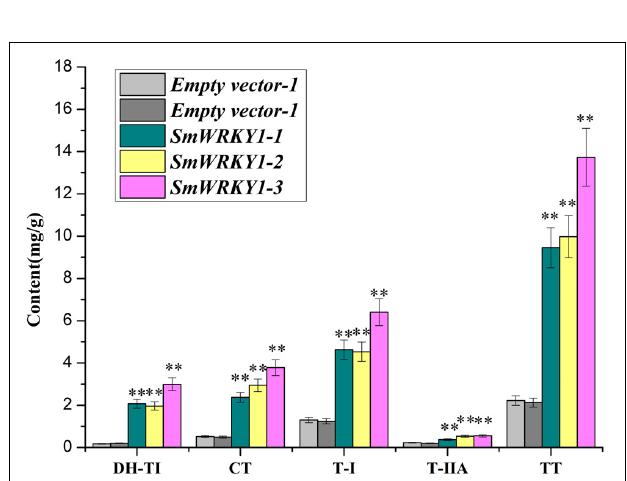
FIGURE 8 | The production of tanshinone in SmWRKY1 transgenic hairy roots compared with control tissue, detected by HPLC. All data are means of three replicates, with error bars indicating Standard Deviation. ∗ , significant at P < 0.05, ∗∗ , highly significant at P < 0.01.